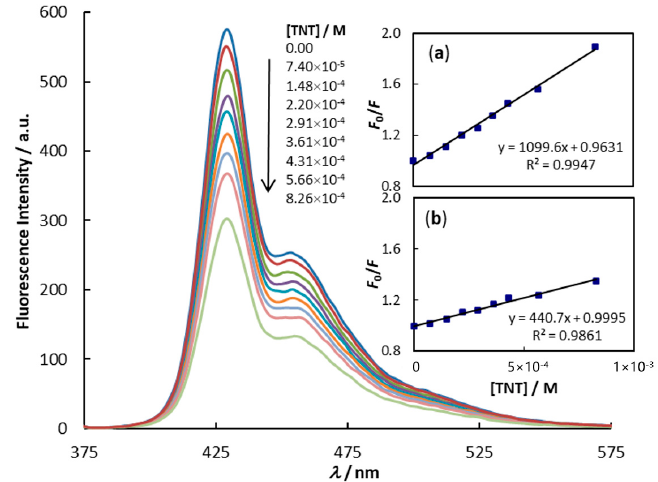
Figure 1. Emission spectra of Calix-PPE-2,7-CBZ (6.0 × 10 − 7 M in CHCl 3 ) after successive additions of 2,4,6-trinitrotoluene (TNT) ( λ exc = 360 nm). Inset: Stern-Volmer uncorrected ( a ) and corrected ( b ) plots.